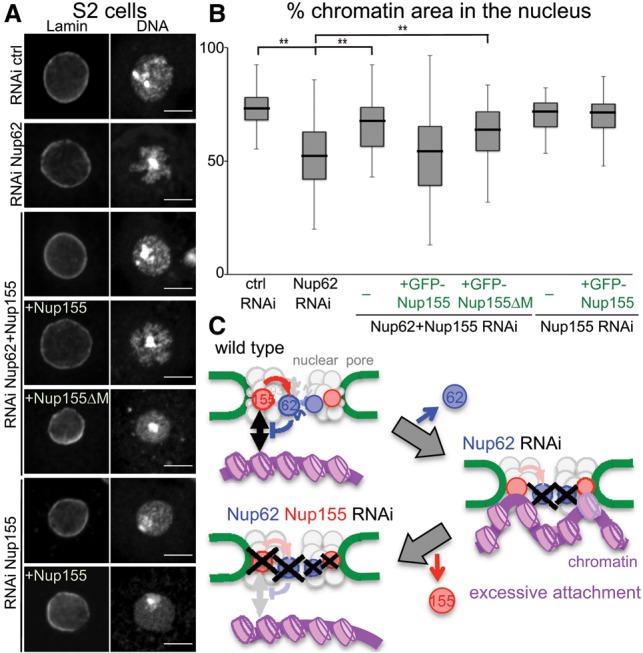
Loss of Nup62 disturbs chromatin distribution in somatic cells, which is rescued by codepletion of Nup155. (A) RNAi-treated (control, Nup62, Nup155, or Nup62 + Nup155) S2 cells were immunostained for Lamin and DNA. Some batches transiently expressed GFP-tagged RNAi-resistant full-length Nup155 (Nup155) and Nup155 lacking the chromatin-binding region (Nup155ΔM). Bar, 5 µm. (B) The proportion of the area occupied by chromatin compared with the entire nuclear area (Lamin). The box represents the middle two quartiles, and the whiskers represent the top and bottom quartiles. 23 ≤ n ≤ 48. (**) P < 0.01, a significant difference from Nup62 RNAi. (C) Model for the chromatin attachment state controlled by an internal regulatory circuit in the NPC.